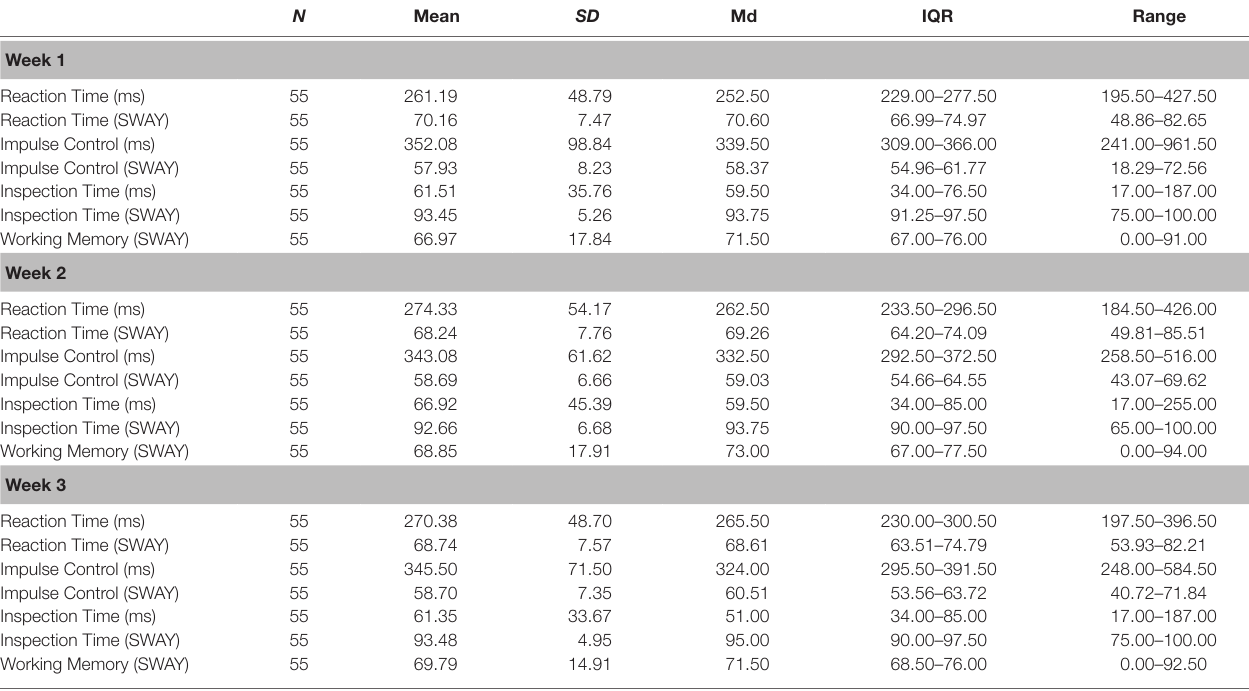
TABLE 1 | Descriptive statistics for the SWAY mobile cognitive